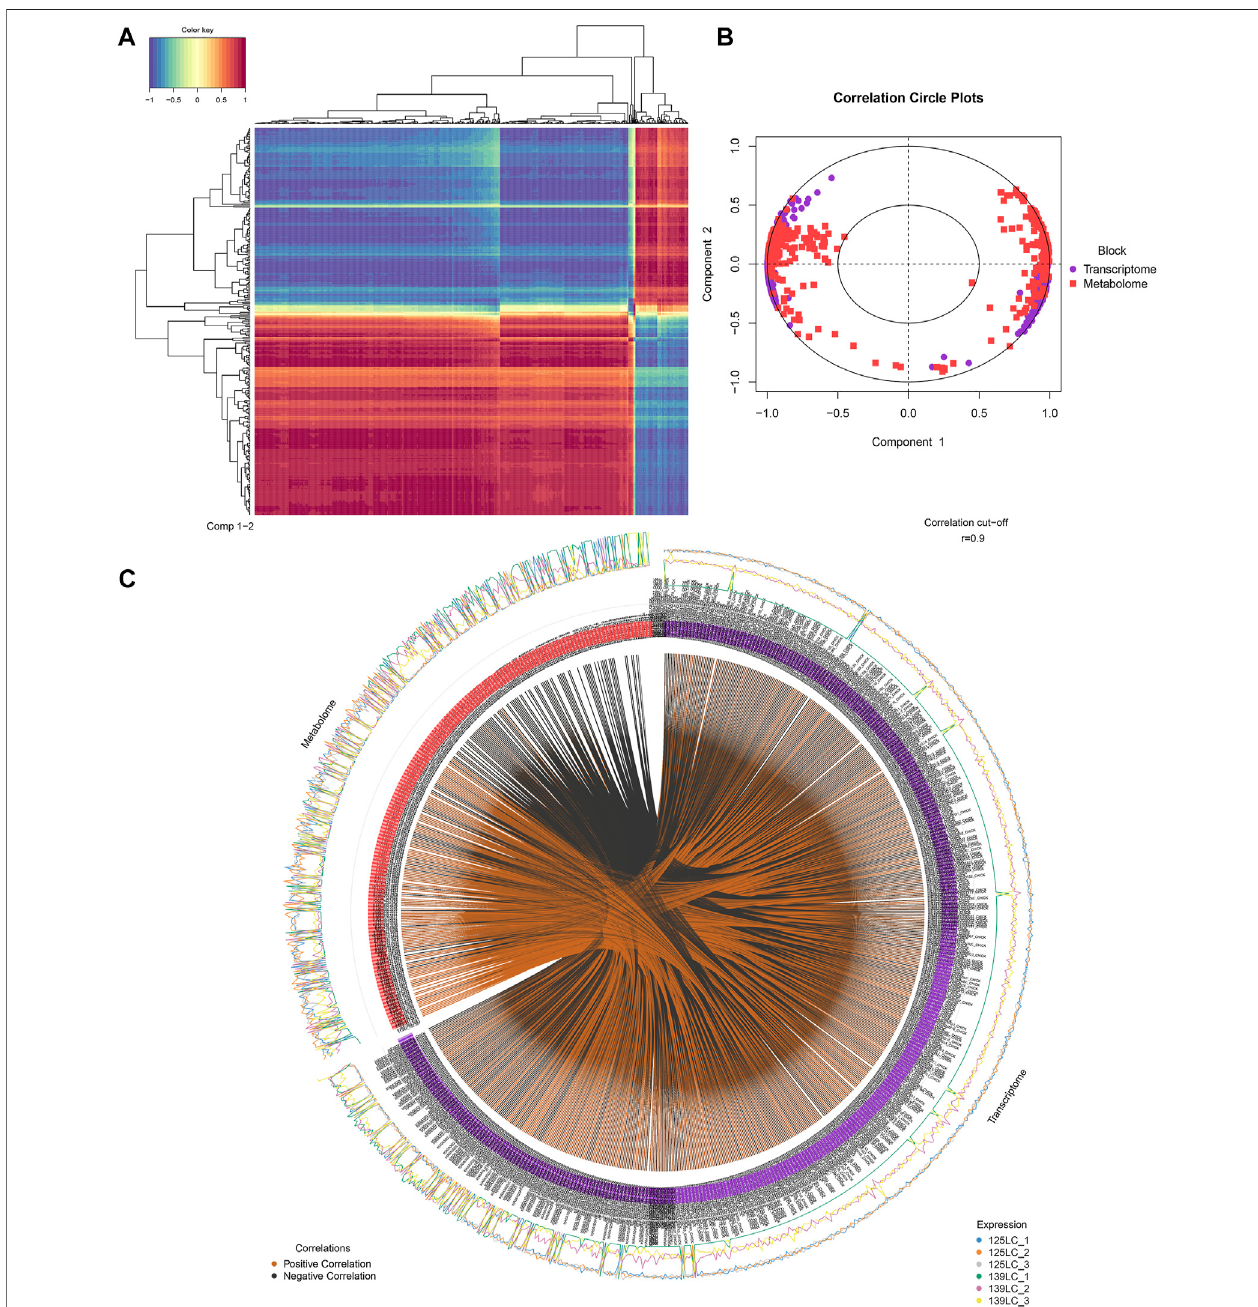
FIGURE6| Integrativeanalyses between DEPsandDMs inovarytissues during sexual maturity. (A) Thecorrelationclusterheatmap betweenDEPsand DMs. (B) The concentric circles of correlation between DEPs and DMs. (C) The circos diagram of the correlation between DEPs and DMs.